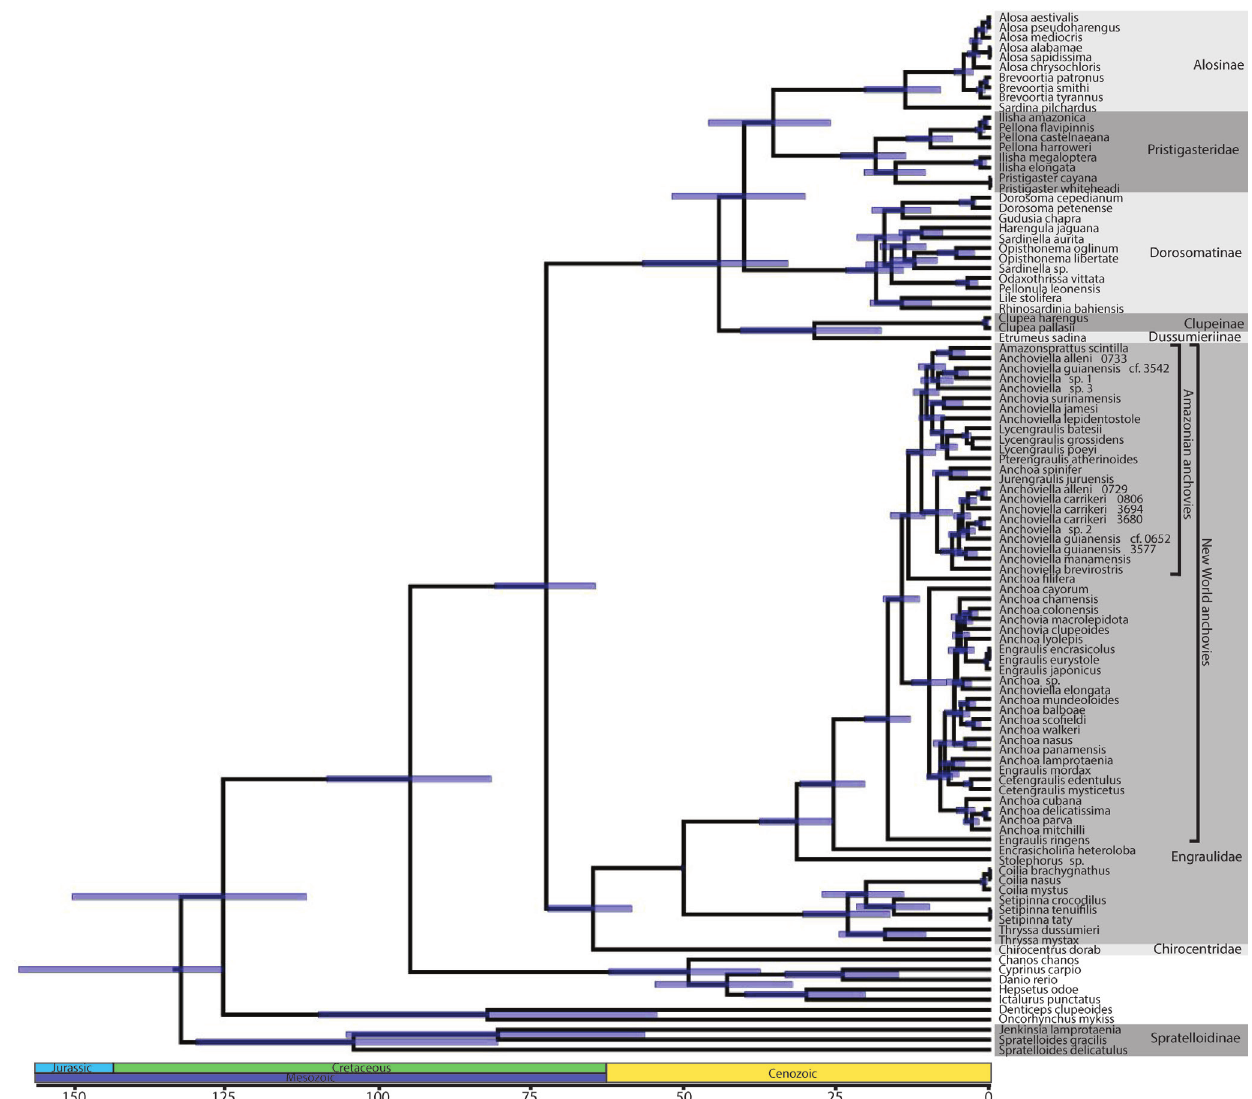
Fig. 2. Time-calibrated clupeoid phylogeny resulting from Bayesian analysis of the mtDNA dataset in BEAST v.2.4.5. Time, in millions of years, is shown along the x-axis. Node bars show the 95% highest posterior density interval of divergence time